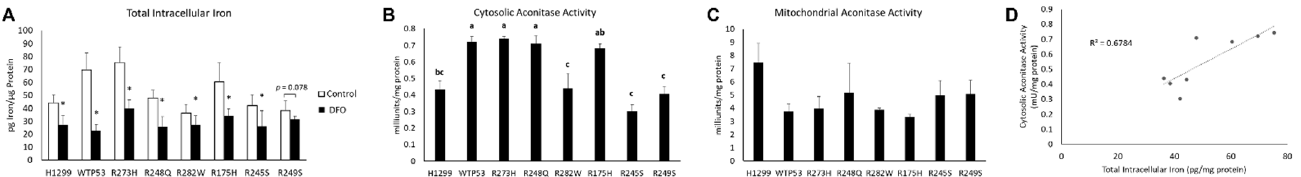
Figure 3. Mutant TP53 expression influences intracellular iron availability and the activity on iron- containing enzymes. ( A ) Total intracellular iron in cells expressing distinct TP53 mutation types under control conditions and following treatment with 50 µM DFO for 48 h. ( B ) Cytosolic ( C ) and mitochondrial aconitase activity in cells expressing distinct TP53 subtypes. ( D ) Cytosolic aconitase activity is directly correlated to levels of intracellular iron under control conditions. * Denotes statistical difference from respective control, p < 0.05. Superscripts (a, b, c) denote statistical difference between TP53 subtypes. Subtypes with the same superscripts are not statistically different. Error bars indicate SEM.